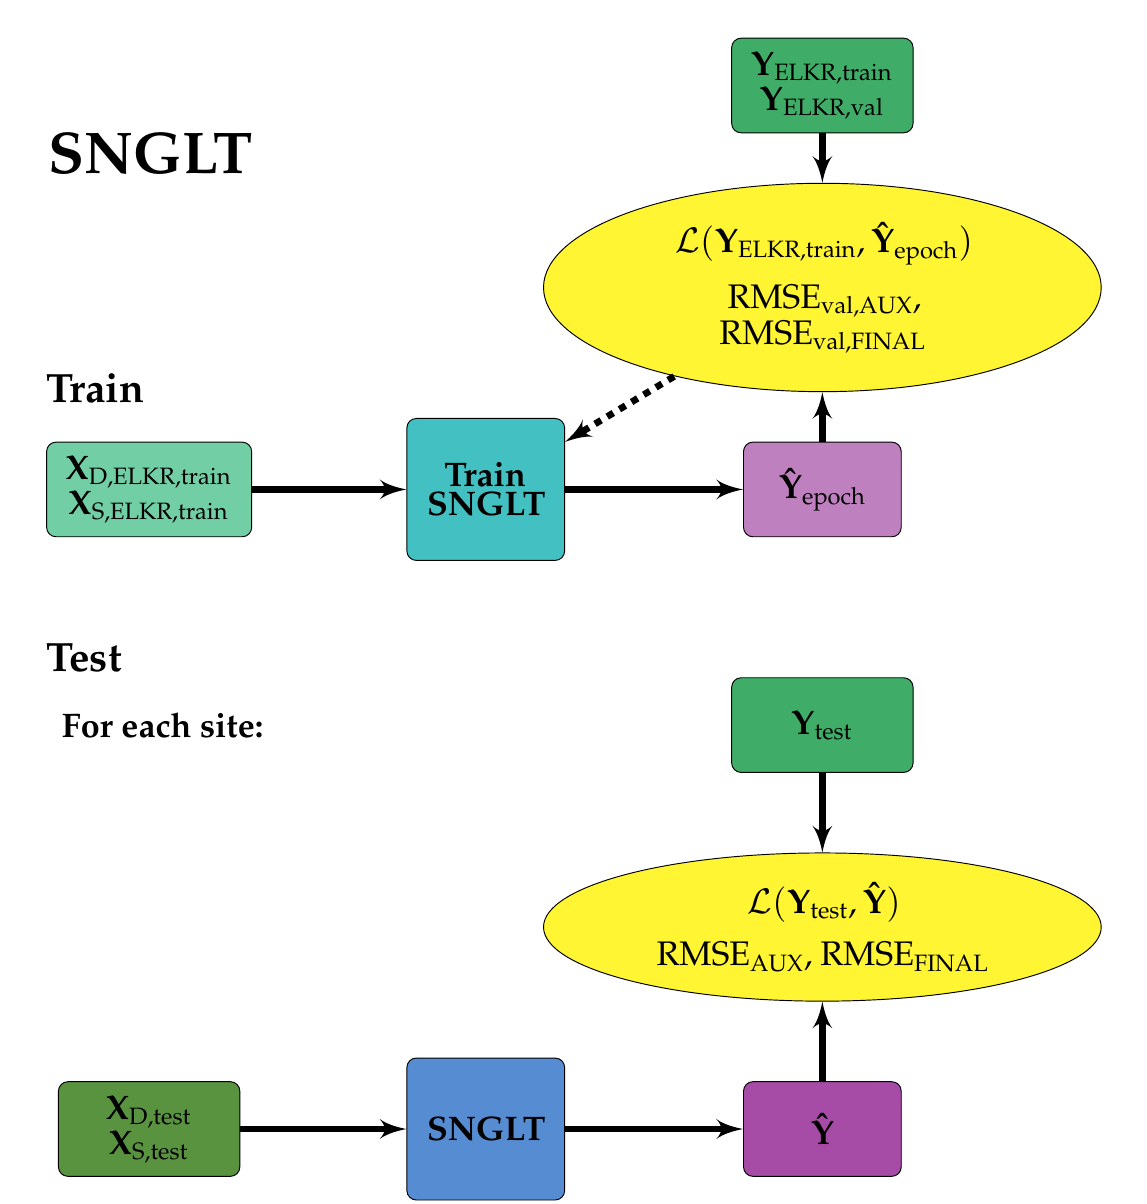
Figure 3. SNGLT model design. Solid arrows indicate the forward flow of information, dashed arrows indicate information used to make updates to model weights and/or inform early stopping. Training data were from the ELKR site only. The trained model was then applied to each site